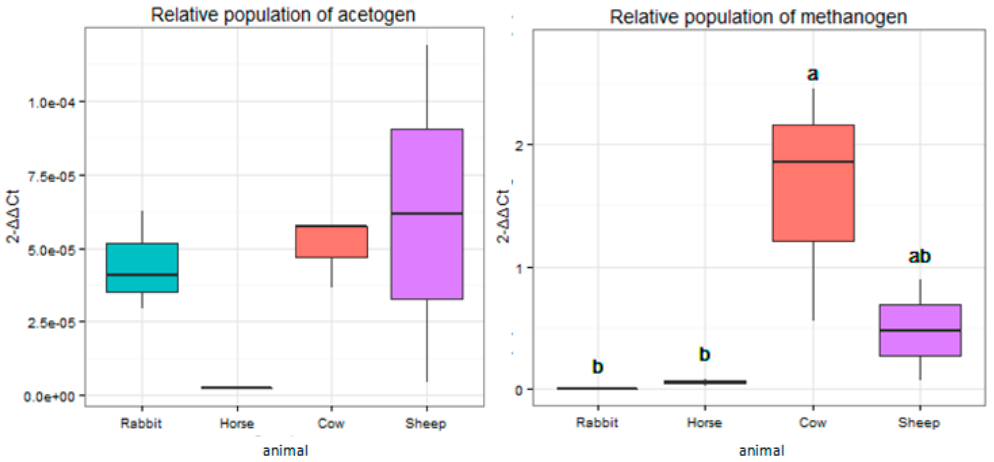
Figure 5. The relative abundance of fhs and mcrA genes in the rumens of cows and sheep, the ceca of rabbits, and the feces of horses. The relative abundance was expressed as the ratio of the target gene to the 16S rRNA genes in total bacteria. Groups with different superscripts means they significantly differ ( p <